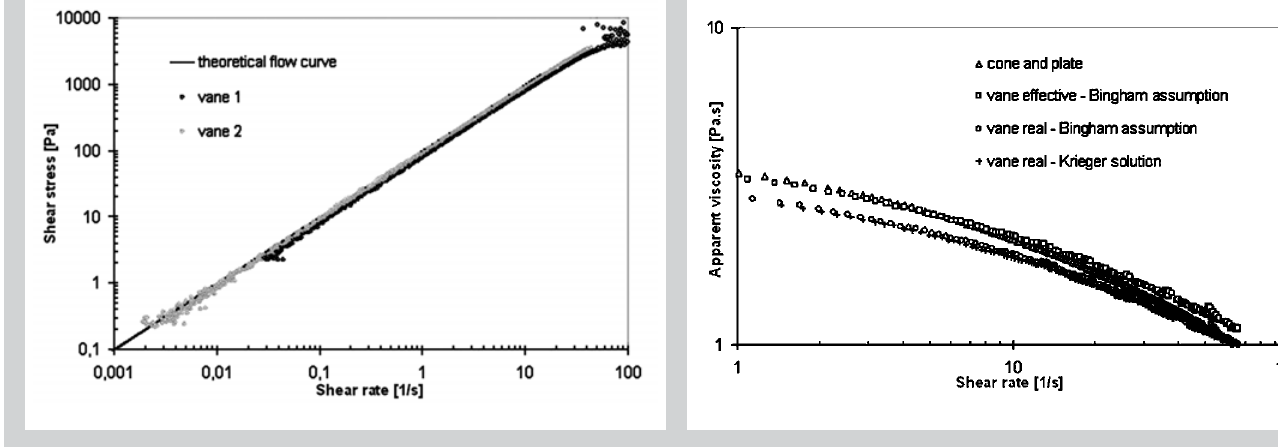
Figure 1 (left): Vane shear flow curves prediction of silicon oil compared to its theoretical flow curve. Figure 2: Flow curves of non-Newton- ian CMC